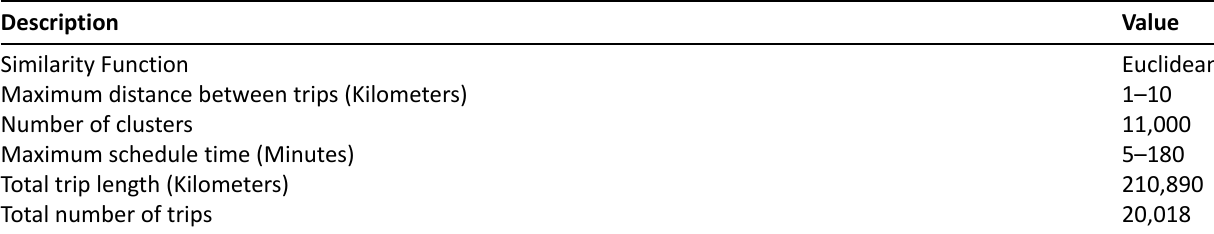
Figure 7. Effect of number of clusters and maximum schedule time on (a) saved kilometers (b) number of saved trips. Table 5. Simulation set up parameters (case study